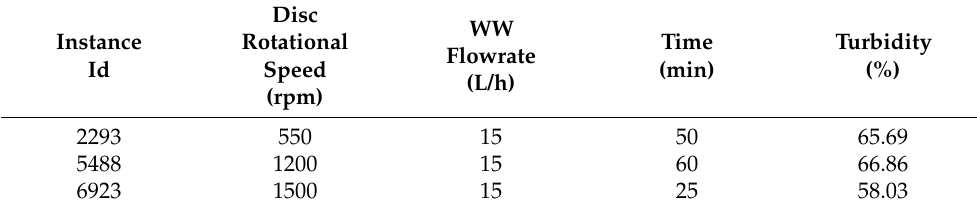
Table 6. Best values in the original dataset.